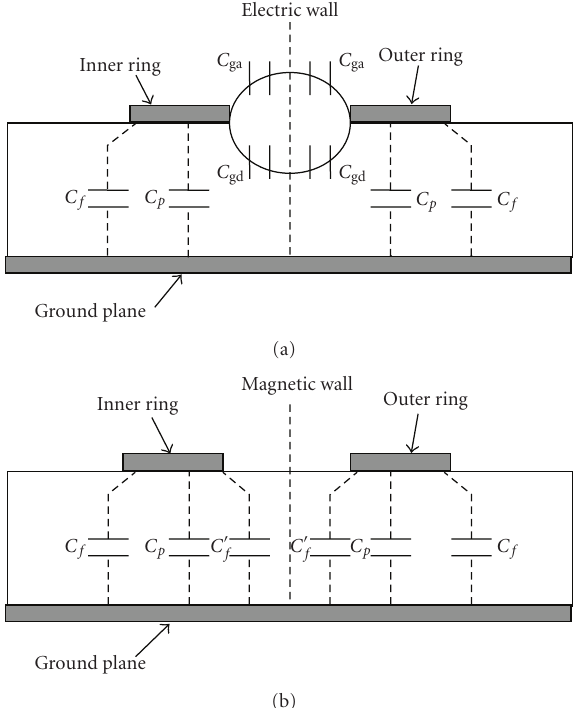
Figure 2: (a) Odd mode capacitances of coupled microstrip lines geometry. (b) Even mode capacitances of coupled microstrip lines geometry.